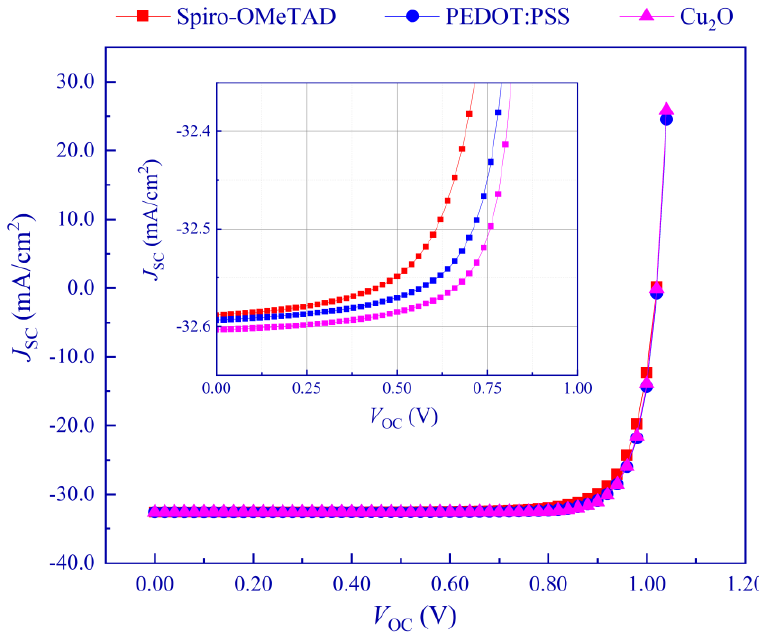
Figure 10. Current-voltage characteristics of perovskite solar cells with different hole-transport layers.